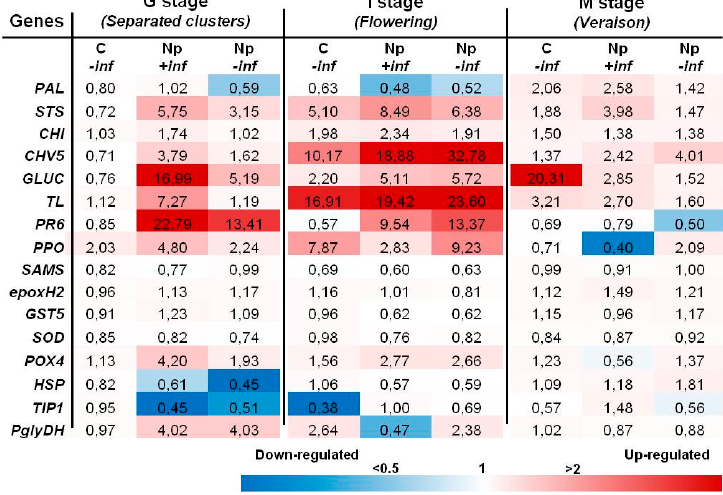
Figure 2. Expression levels of the selected 16 genes recorded by RT-qPCR in N. parvum artificially-inoculated stems at different phenological stages. Values (the mean of three technical replicates) represent the expression levels ( ΔΔ C t ) of reported conditions relatively to the control (C + inf). Expression of a given gene was considered up- or down-regulated when the value of relative expression was >2-fold or <0.5-fold compared to the control, respectively. Due to the similarity to control values, the last eight genes were not considered in the following trials.